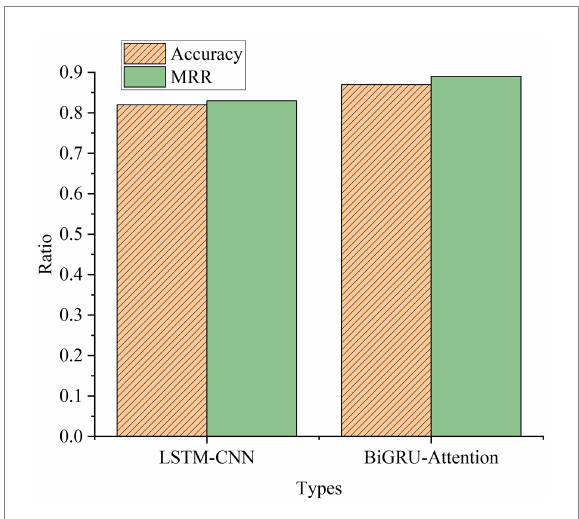
FIGURE 18 A comparison of the experimental results of the